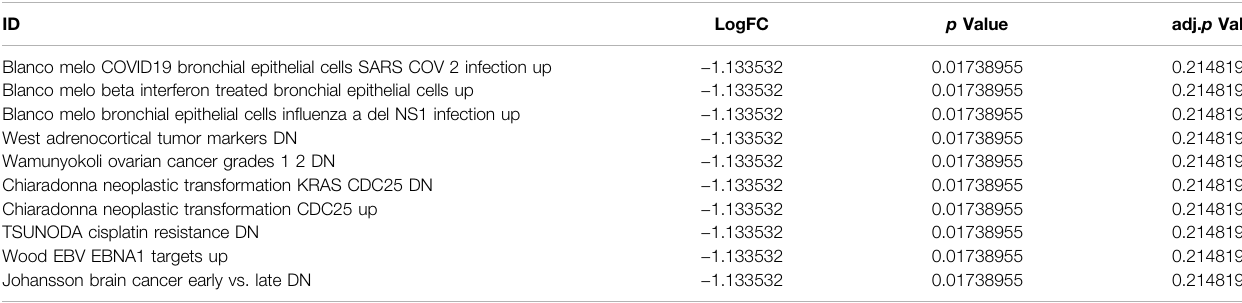
TABLE 4 | GSVA enrichment